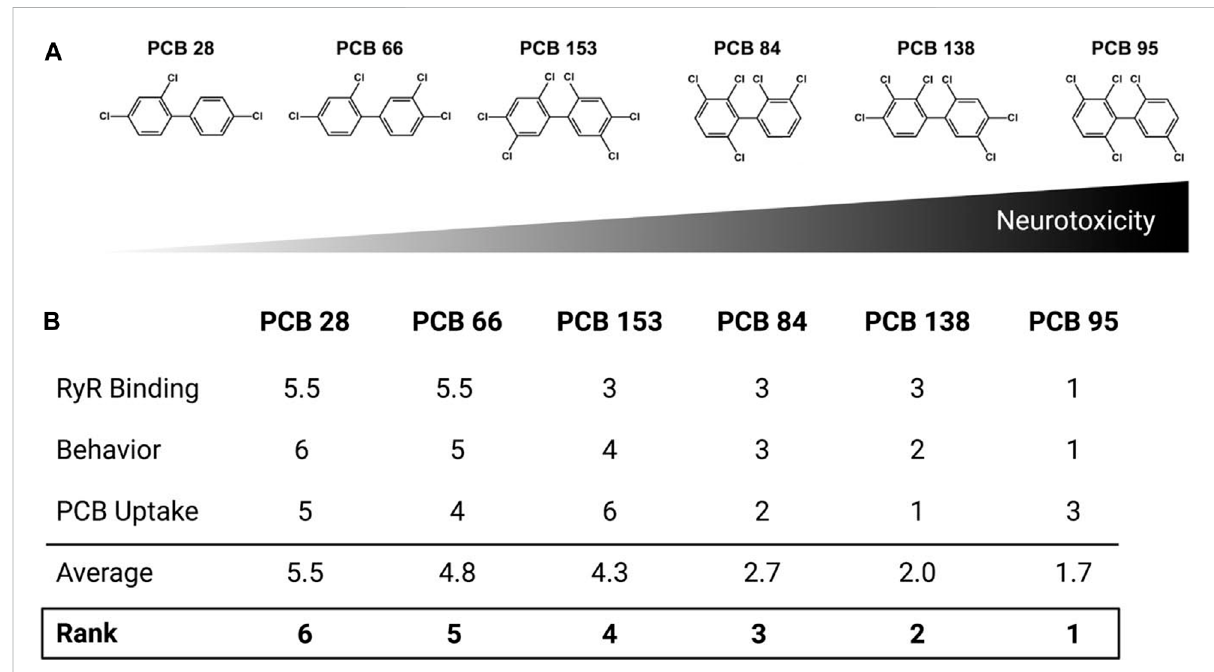
FIGURE 5 Congenerrankings.Rankingswereassignedtoeachcongenerbasedontheaveragerankingfromthreeassays:RYRbinding,behaviorandbody burden. (A) Relative congener neurotoxicity in the larval zebra fi sh with PCB 95 being the most potent. (B) Individual scores for each assay, average ranking and overall